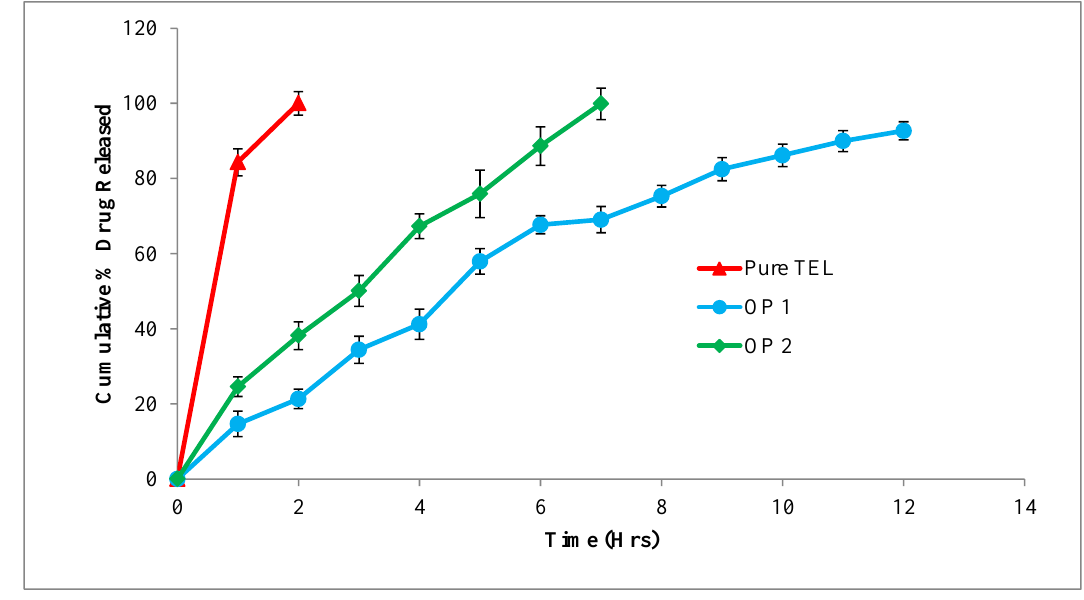
Figure 8. In vitro drug-release study of optimized formulation (OP1 and OP2) in comparison with pure TEL using simulated gastric fluid (pH 1.2) as dissolution medium.